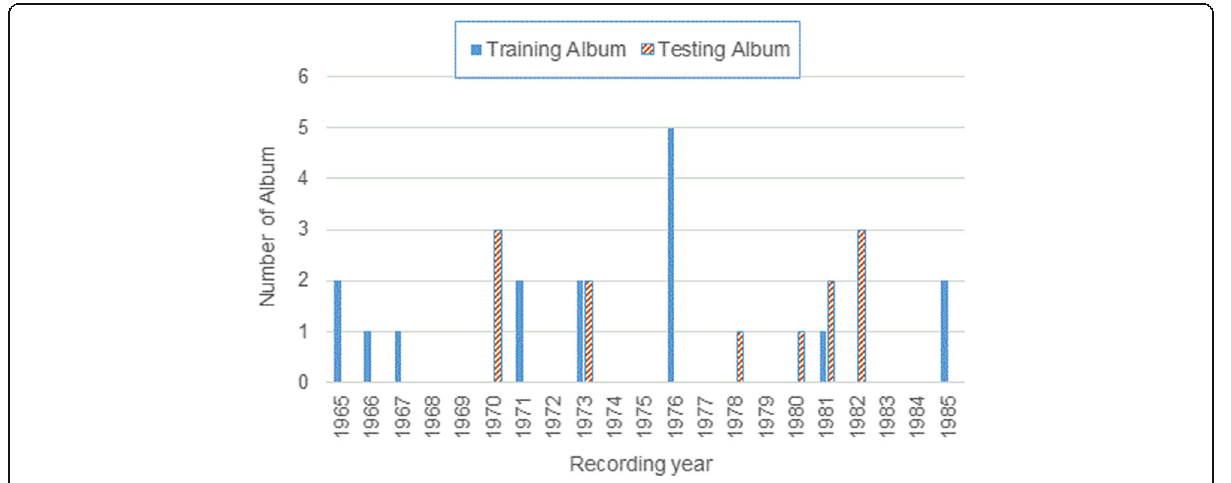
Fig. 4 Distribution of training and testing albums of a singer